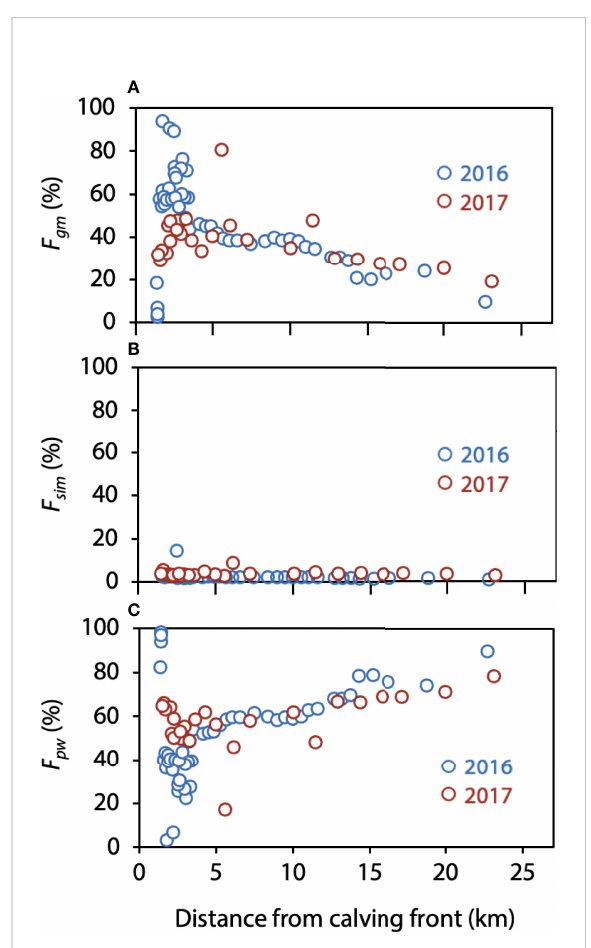
FIGURE 5 Distributions of the (A) glacial meltwater fraction ( F gm ), (B) sea ice meltwater fraction ( F sim ), and (C) polar water fraction ( F pw ) in relation to the calving